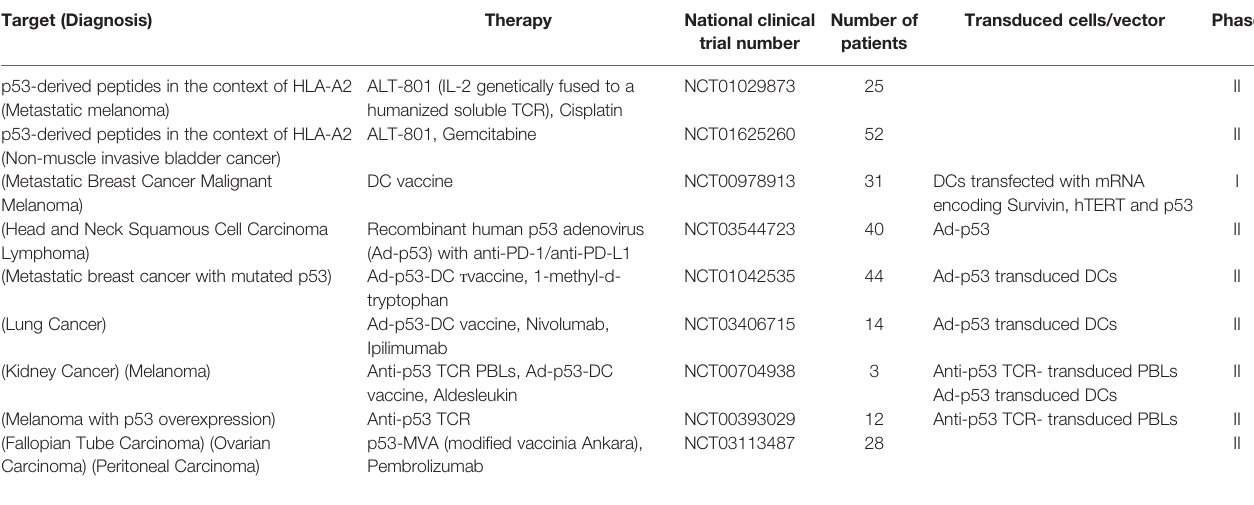
TABLE 1 | The list of clinical stage therapies targeting p53 mutant cancers. Target (Diagnosis) Therapy National clinical